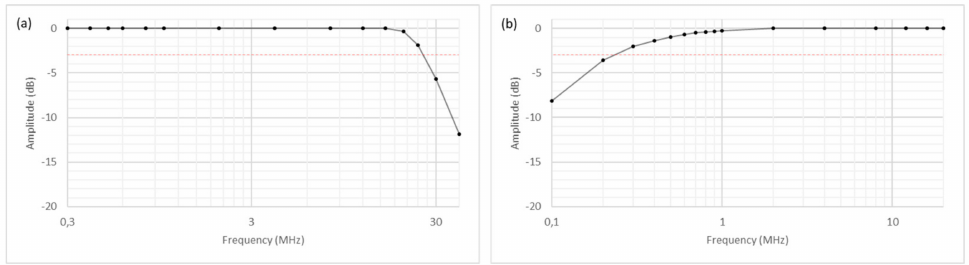
Figure 9. Transmit bandwidth ( a ) and receive bandwidth ( b